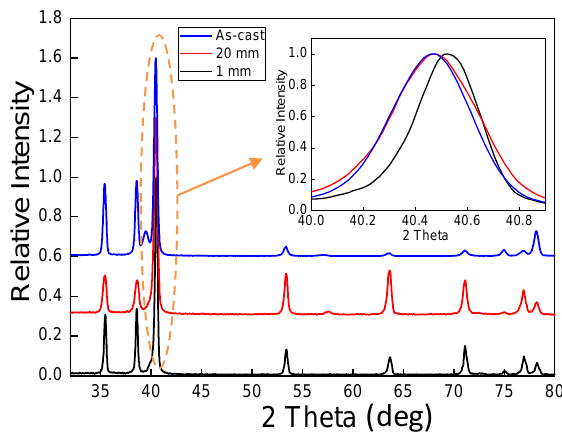
Figure 5. XRD patterns for 1 mm and 20 mm EBM-built and as-cast Ti64 samples.